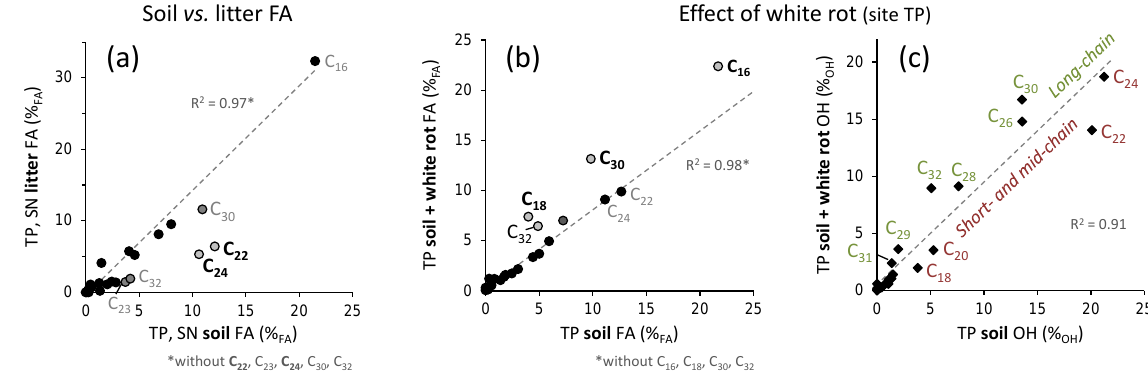
Figure 4. Correlations of compound class-specific relative abundances of (a) n -alkanoic acids in soils and leaf litter of the low-altitude, oak-dominated sites (TP, SN), (b) n -alkanoic acids and (c) n -alcohols in the two soil samples from site TP, one of which is affected by white rot. The patterns illustrate enrichment of mid-chain FA (C 22 , 24 ) from leaf litter to soil and of long-chain n -alcohols (C 26 − 32 ) as well as long-chain FA (C 30 , 32 ) and short-chain FA (C 16 , 18 ) due to visibly enhanced fungal degradation (white rot) within the soil at site TP. Chain-length shifts in the latter suggest either selective degradation or biosynthesis of specific compounds by